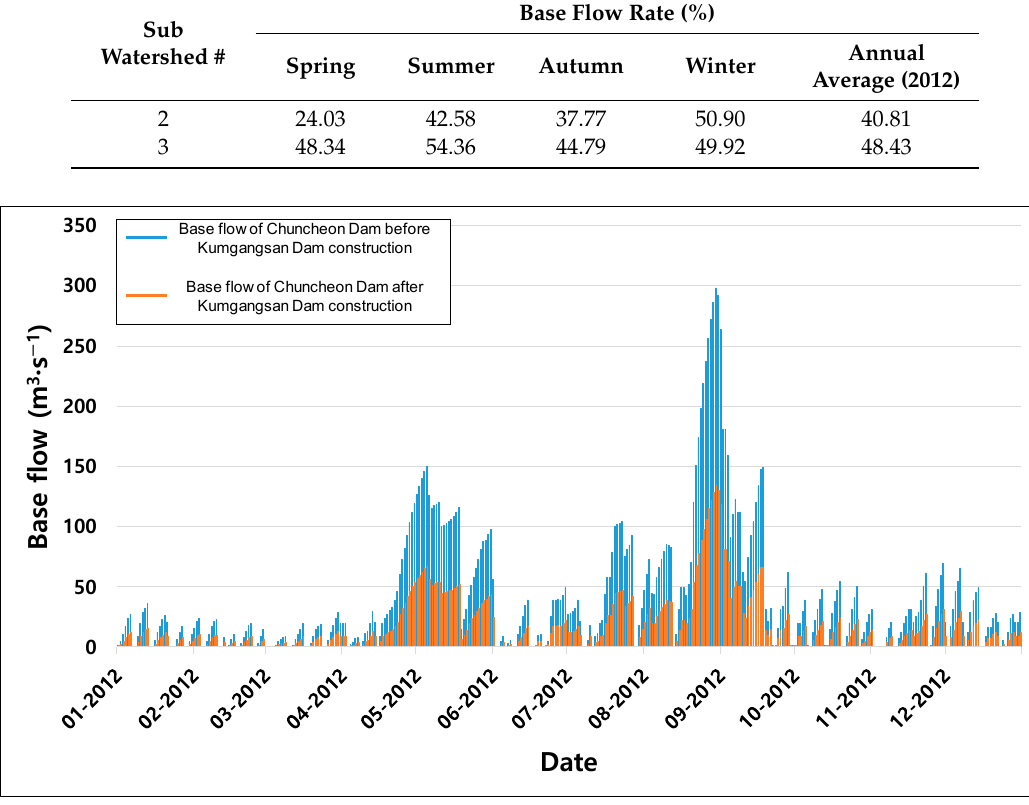
Figure 9. Base flow of the Chuncheon Dam before and after Kumgangsan Dam construction. Table 9 . Seasonal and annual average base flow in subwatershed #4 in WSG 2 and #3 in WSG 4. WSGs SubWatershed #